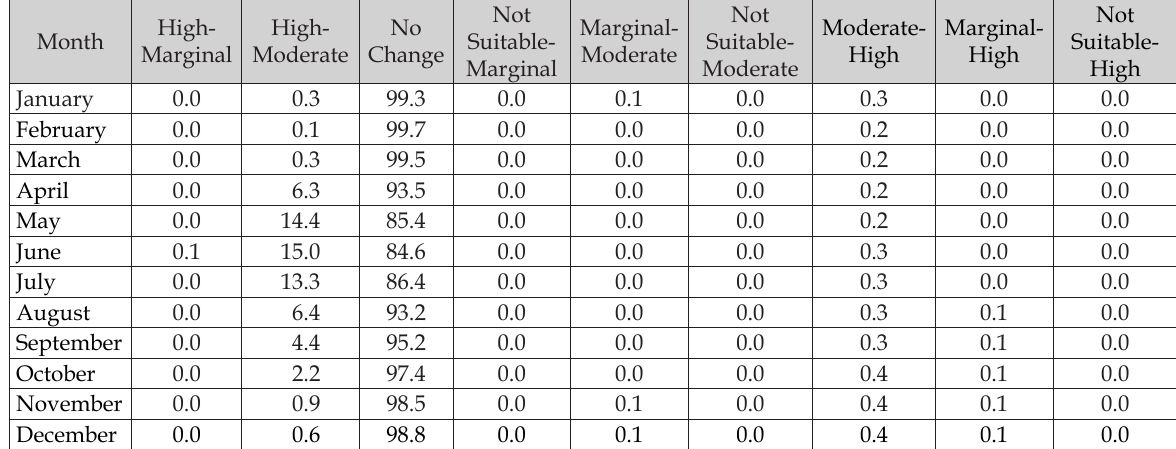
Table 5. Monthly proportion (%) of changes in climatic suitability due to change in temperature under future climate